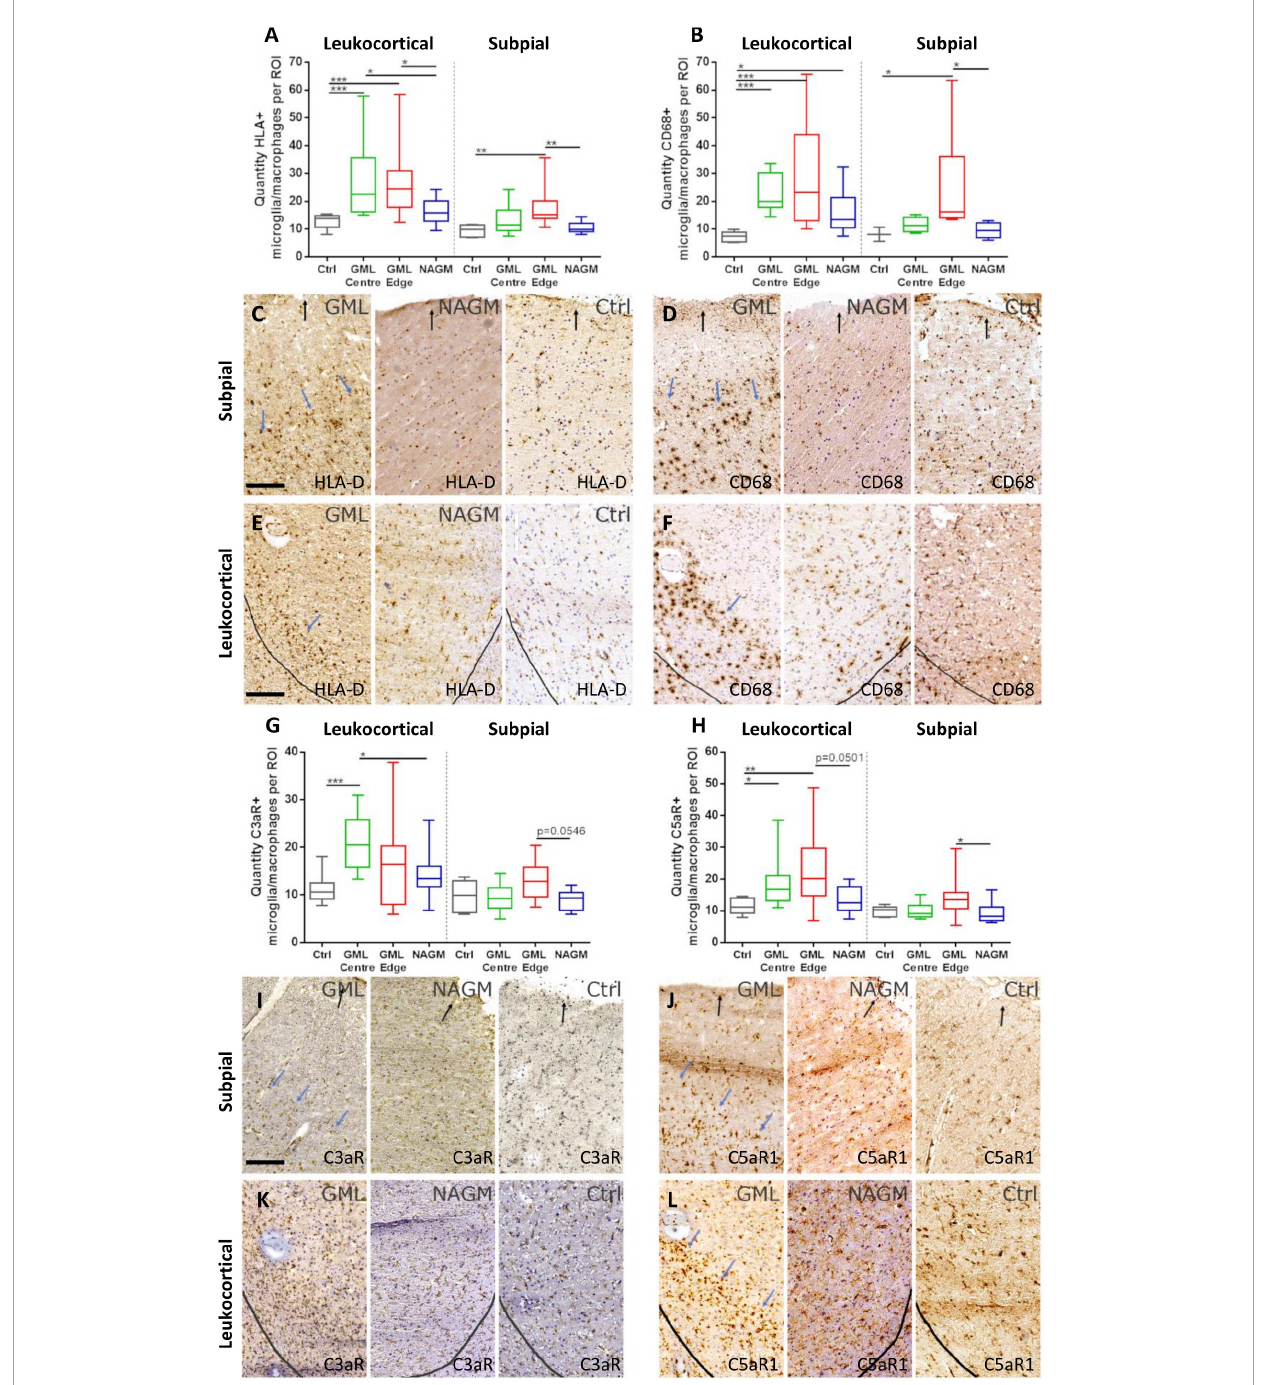
FIGURE5 C5aR1 + microglia/macrophages are increased in density at the expanding grey matter lesion edge. Microglia/macrophages immunopositive for activation markers HLA-D and CD68 were quantified in leukocortical and subpial GM lesions (A,B) . The density of immunostained cells were significantly increased at the centre and edge, and at the edge of GM lesions, respectively, for both markers compared to non-neurological control GM at matched anatomical cortical level (A,B) . Examples of HLA-D (C,E) and CD68 (D,F) immunostaining in GM lesion (GML), normal appearing GM (NAGM), and control (ctrl). Quantification of C3aR1 + microglia/macrophages revealed a significant increase in quantity at the centre of deep cortical GM lesions compared to controls and NAGM and there were no significant changes in subpial GM lesions (G,I,K) . C5aR1 + microglia/macrophages were significantly elevated at the GM lesion centre and edge of leukocortical GM lesions compared to control GM, and at the GM lesion edge of subpial lesions compared to NAGM (H,J,L) . Blue arrows represent the expanding lesion edge of leukocortical and subpial lesions. Black arrows show the pial surface and grey lines represent the grey/white matter border. Data compared by Kruskal–Wallis and Dunn’s multiple comparison post-test. Scale bars = 100 µ